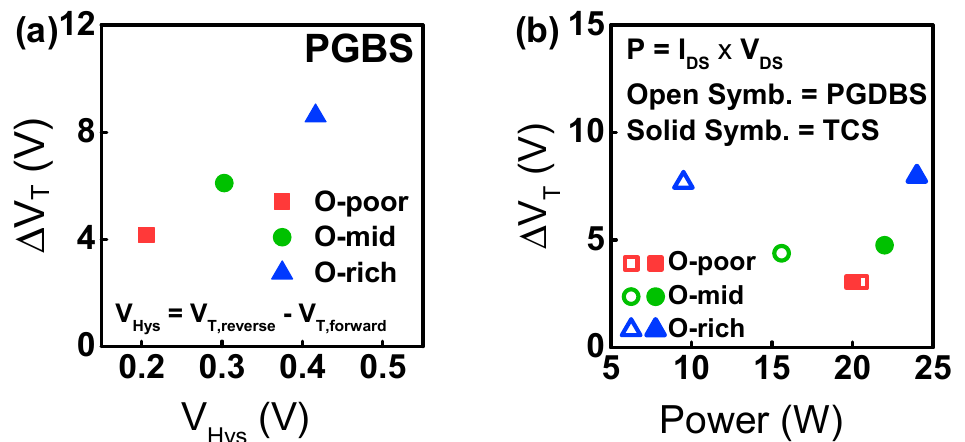
Figure 6. The OFR-dependent relationships ( a ) between Δ V T and V Hys and ( b ) between Δ V T and the average power consumption under PGDBS and TCS. Closed symbols denote PGDBS conditions, and open symbols indicate TCS conditions.